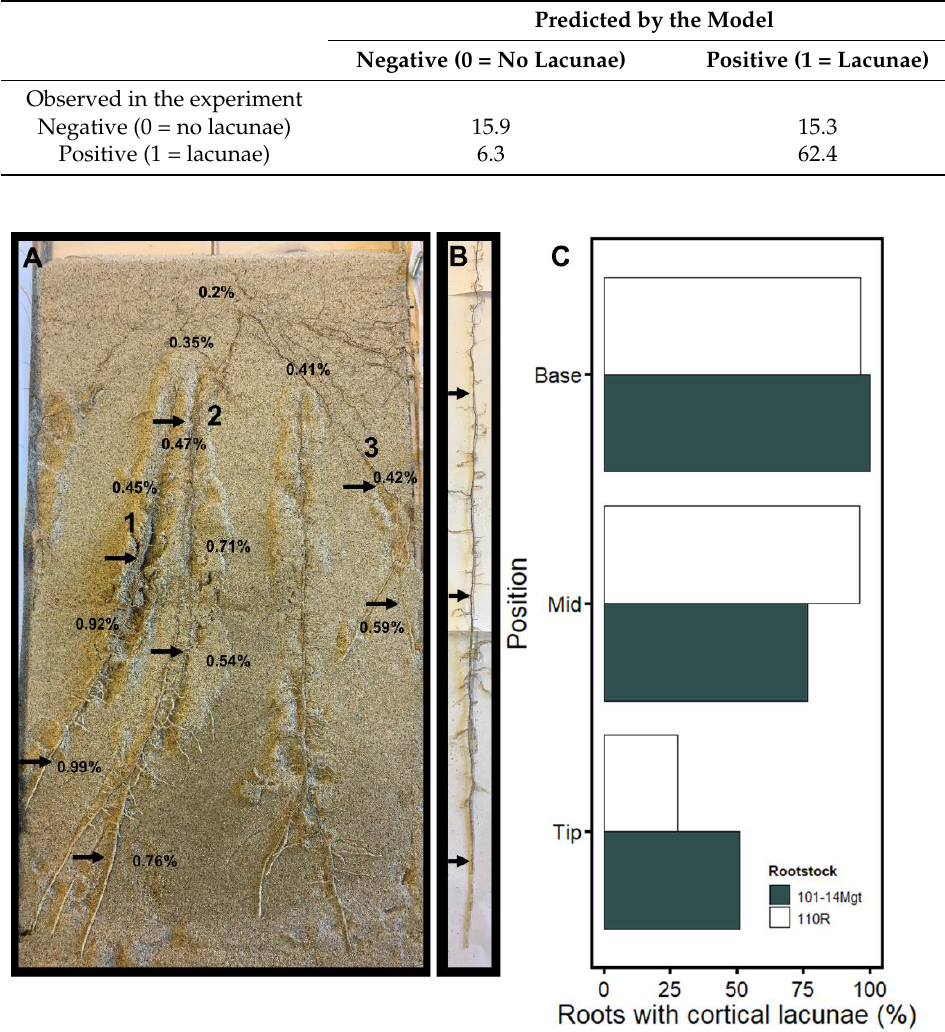
Figure 2. Lacunae mapping along the length of 101-14Mgt and 110R fine roots. Black arrows in panel ( A ) indicate the location of the scanning in three roots associated with a specific soil water content (%) collected adjacent to the root. The extracted root in ( B ) correspond to root 1 in in ( A ). In ( C ), percentage of root showing cortical lacunae in the root base, mid-section, and tip corresponding to the position showed by arrows in ( B ).